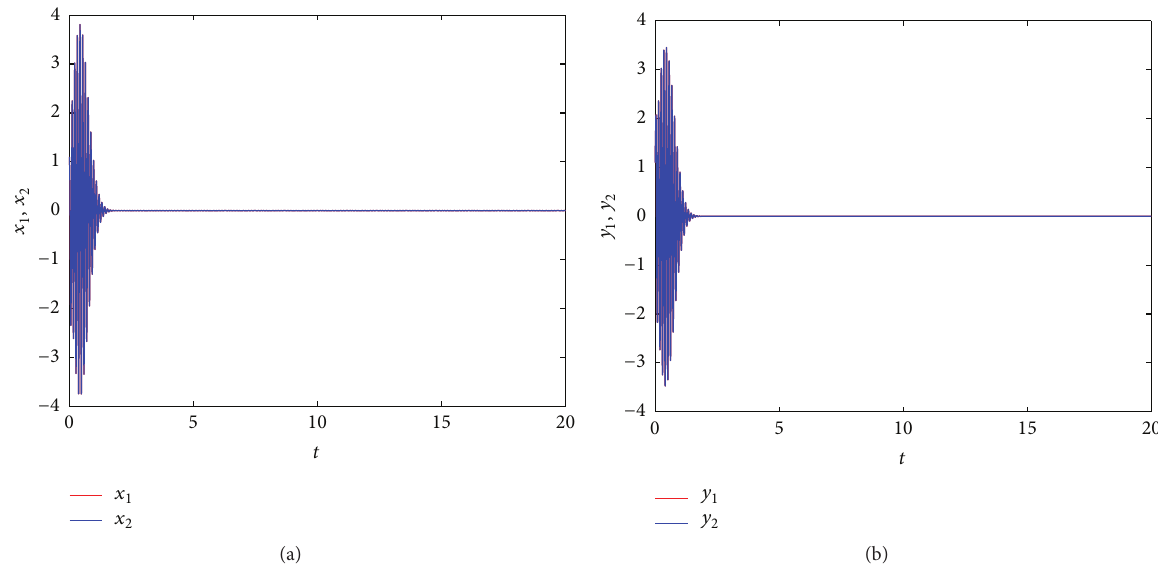
Figure 4: when 𝜏 ∈ [𝜏 − 1 𝜏 + 1 ] , the zero equilibrium is asymptotically stable. 𝑇 = 1 and initial conditions: 1.1 ⋅ (1, 1,1, 1, 1, 1,1, 1) , 𝜏 = 0.0299 .